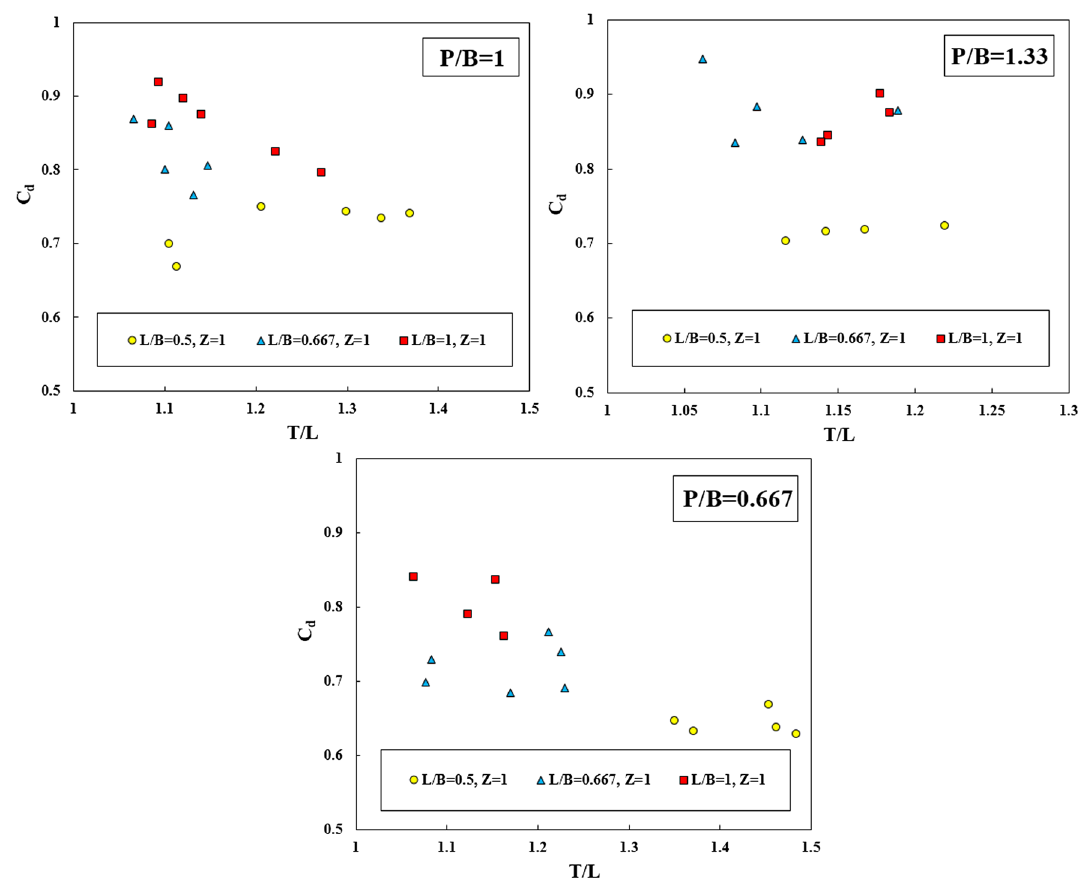
Fig. 7 Variation in C d with T / L (passing flow width to weir crest length) in z = 1 ( P / B = 1.33, 1 and